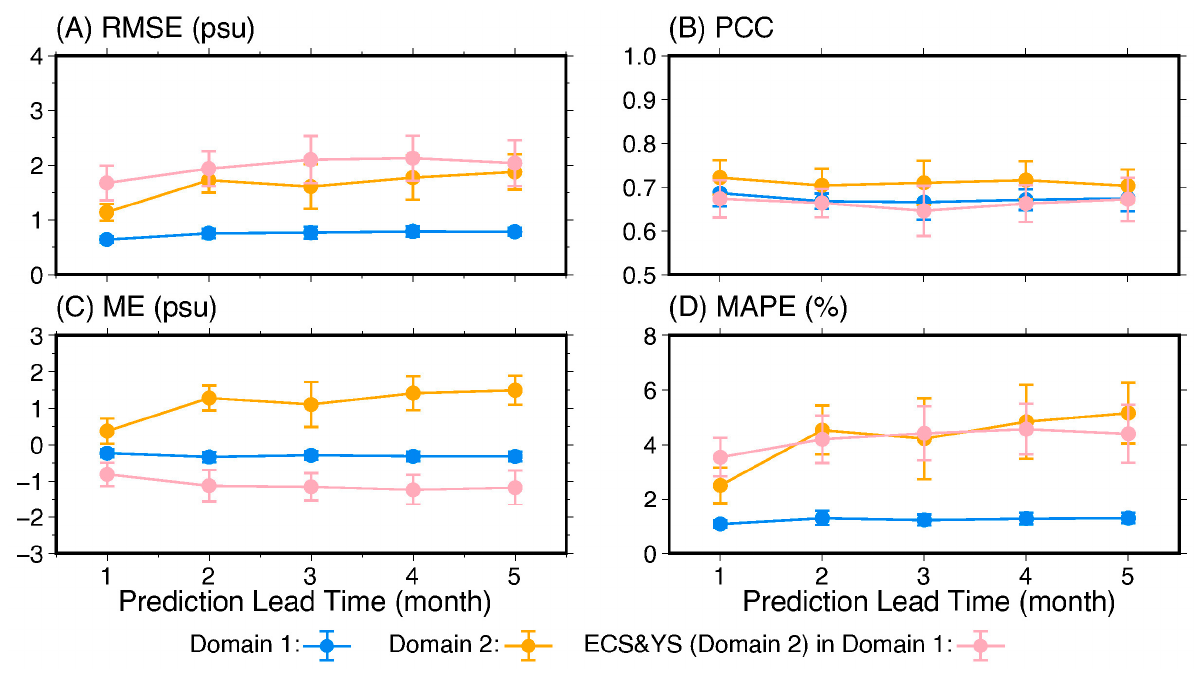
Figure 10. Error estimations of multi-step prediction over Domain 1 (blue) and Domain 2 (orange), and the results for the ECS&YS region in Domain 1 (pink) are also plotted for comparison. Colored dots represent the mean error indices of all the predicted months, while the error bars represent their standard deviations. Note that, due to data availability, the one-month-lead prediction contains 15 months (ended in March 2022), and the five-month-lead prediction only contains 11 months.